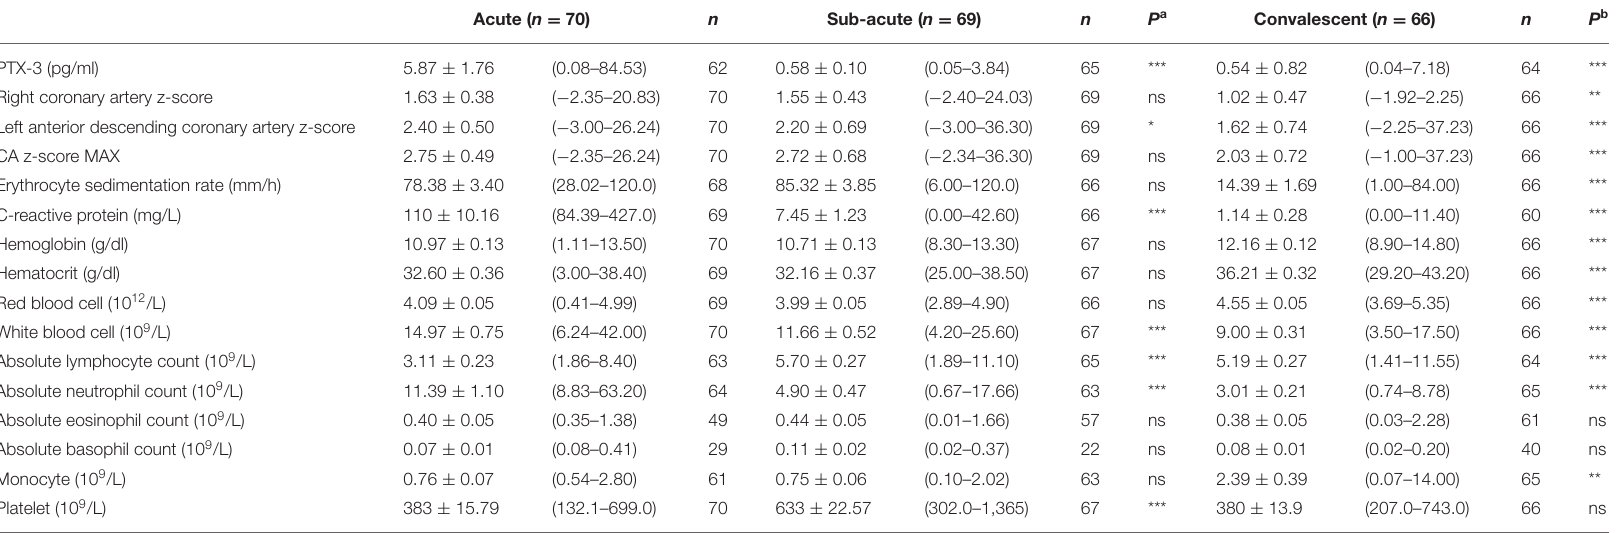
TABLE 2 | PTX-3, coronary artery z-scores, and clinical assessment of inflammation throughout Kawasaki disease (KD)